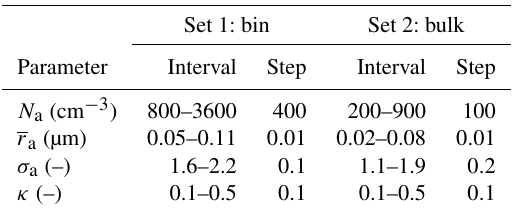
Table 1. Aerosol parameters used for the sensitivity tests using bin and bulk approaches for the aerosol: intervals for values and steps between them. For additional details, the reader is referred to the